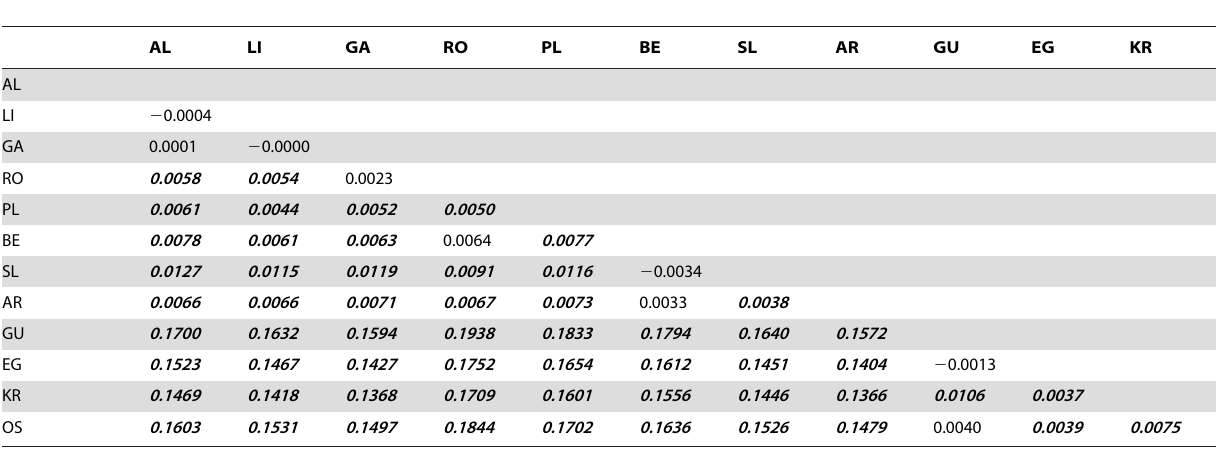
Table 4. Genetic differentiation ( F ST ) between all pairs of sample localities.